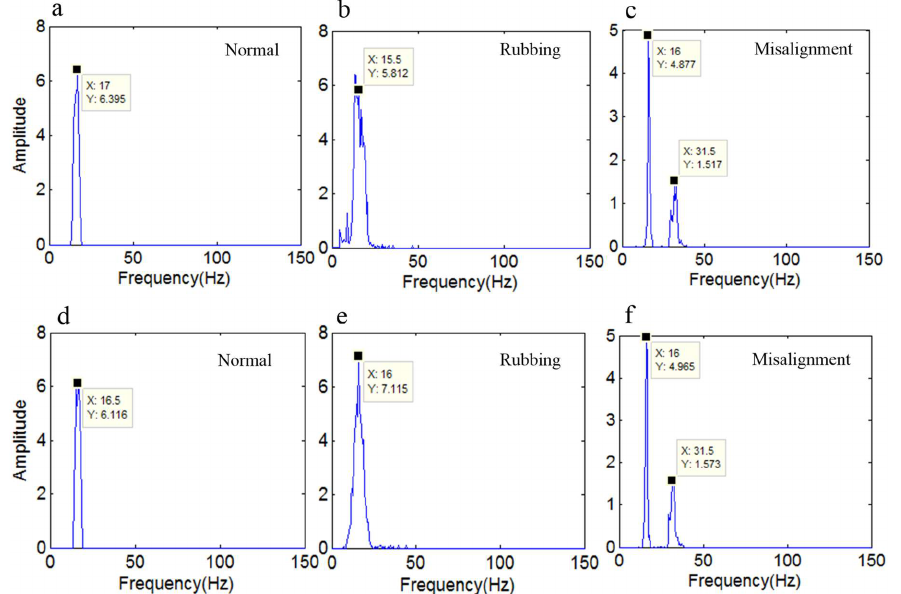
Figure 26. The marginal spectrum under different running states. ( a – c ) show the marginal spectrum of the normal, rubbing, and misalignment running states obtained by the original HHT; ( d – f ) show the marginal spectrum of the normal, rubbing, and misalignment running states obtained by the revised HHT.